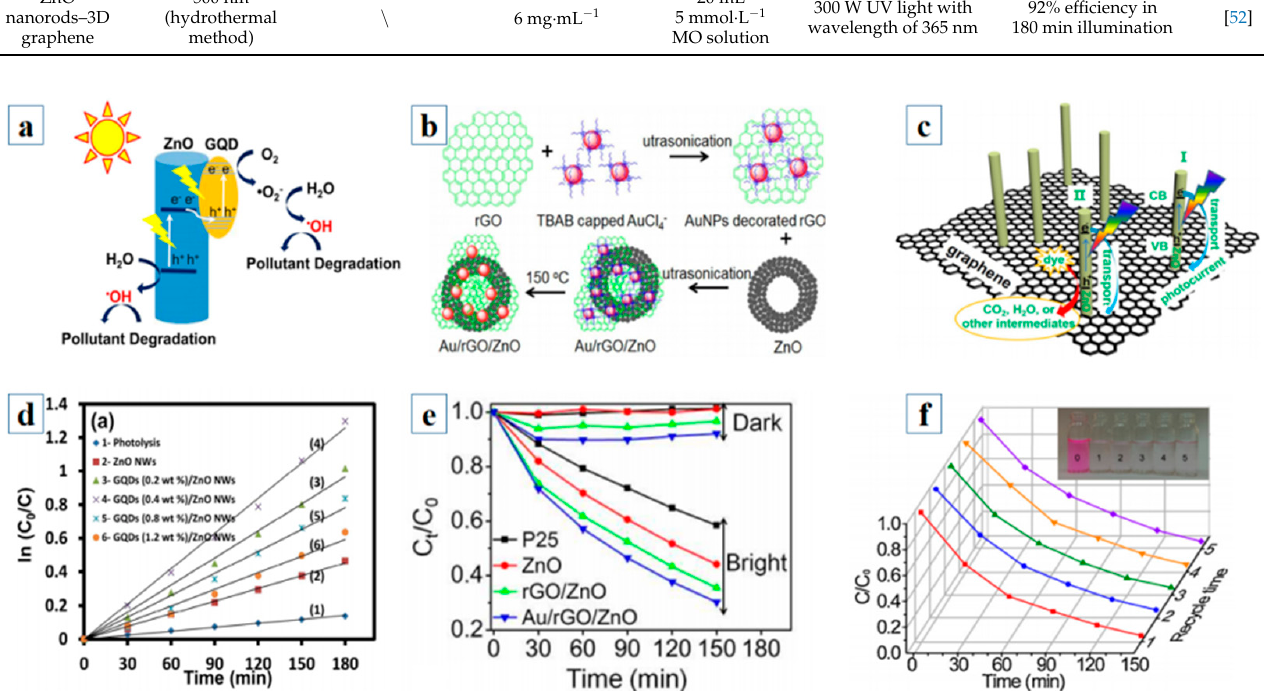
Figure 10. ( a ) The working mechanism of the ZnO–GQD composites; ( b ) schematic illustration of the synthesis of Au/rGO/ZnO hybrid; ( c ) schematic illustration of the photocatalytic mechanism of the ZnO/rGO foam; ( d ) variation of In(C0/C) vs. reaction time under solar irradiation for the ZnO NWs and GQDs/ZnO NWs with different GQD loadings; ( e ) photocatalytic performance of ZnO samples (ZnO, rGO/ZnO and Au/rGO/ZnO) compared with P25; ( f ) recyclable photodegradation of the ZnO/rGO foam for the first, second, third, fourth, and fifth cycles.